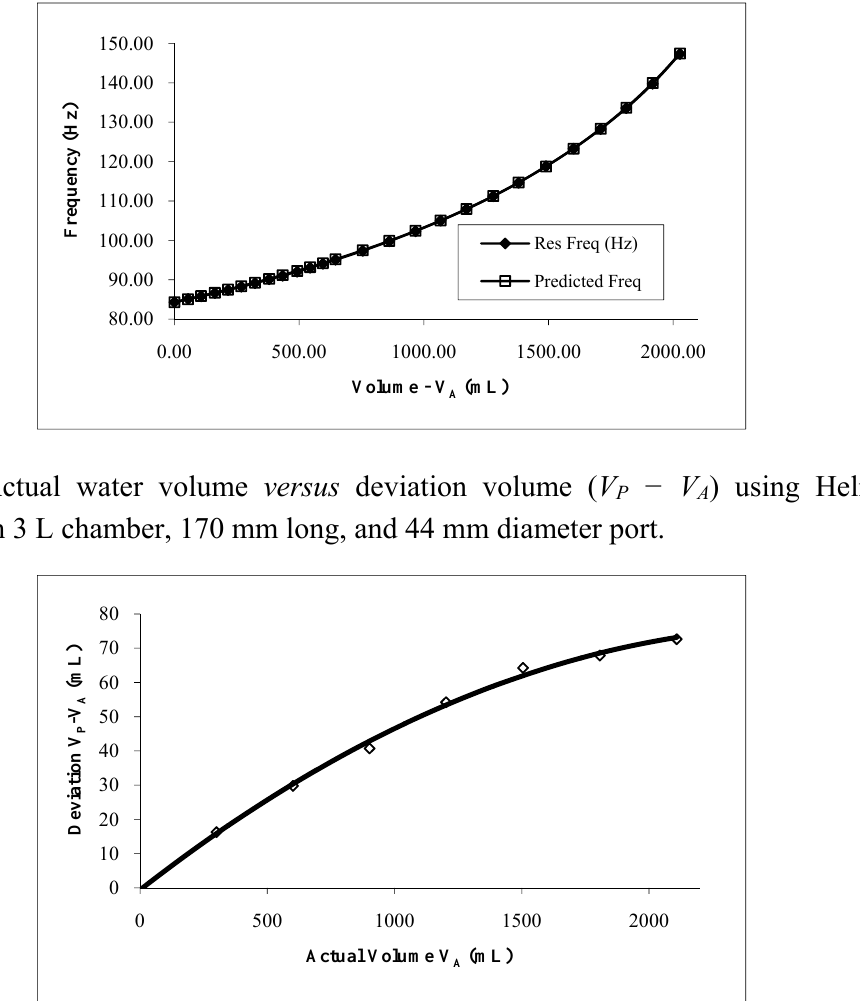
Figure 3. Measured resonant frequency and predicted resonant frequency for varying water fill using 3 L chamber, 170 mm long, and 44 mm diameter port.